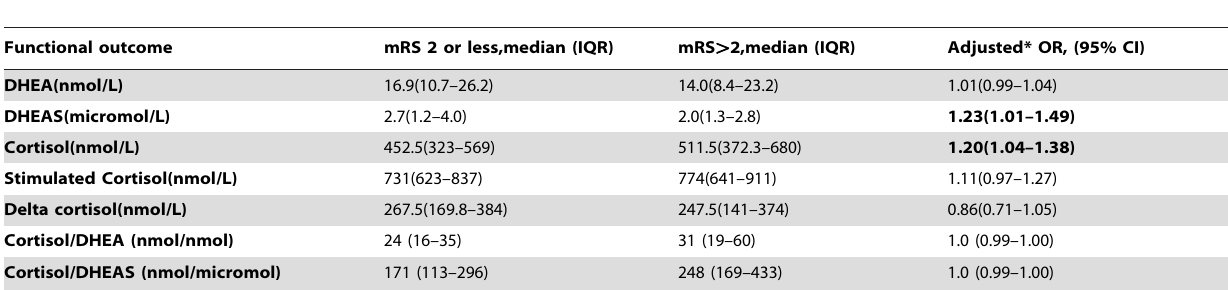
Table 2. Prognostic value of DHEA, DHEAS, basal cortisol, stimulated, delta cortisol, and the ratios cortisol/DHEA and cortisol/ DHEAS for functional outcome after 1